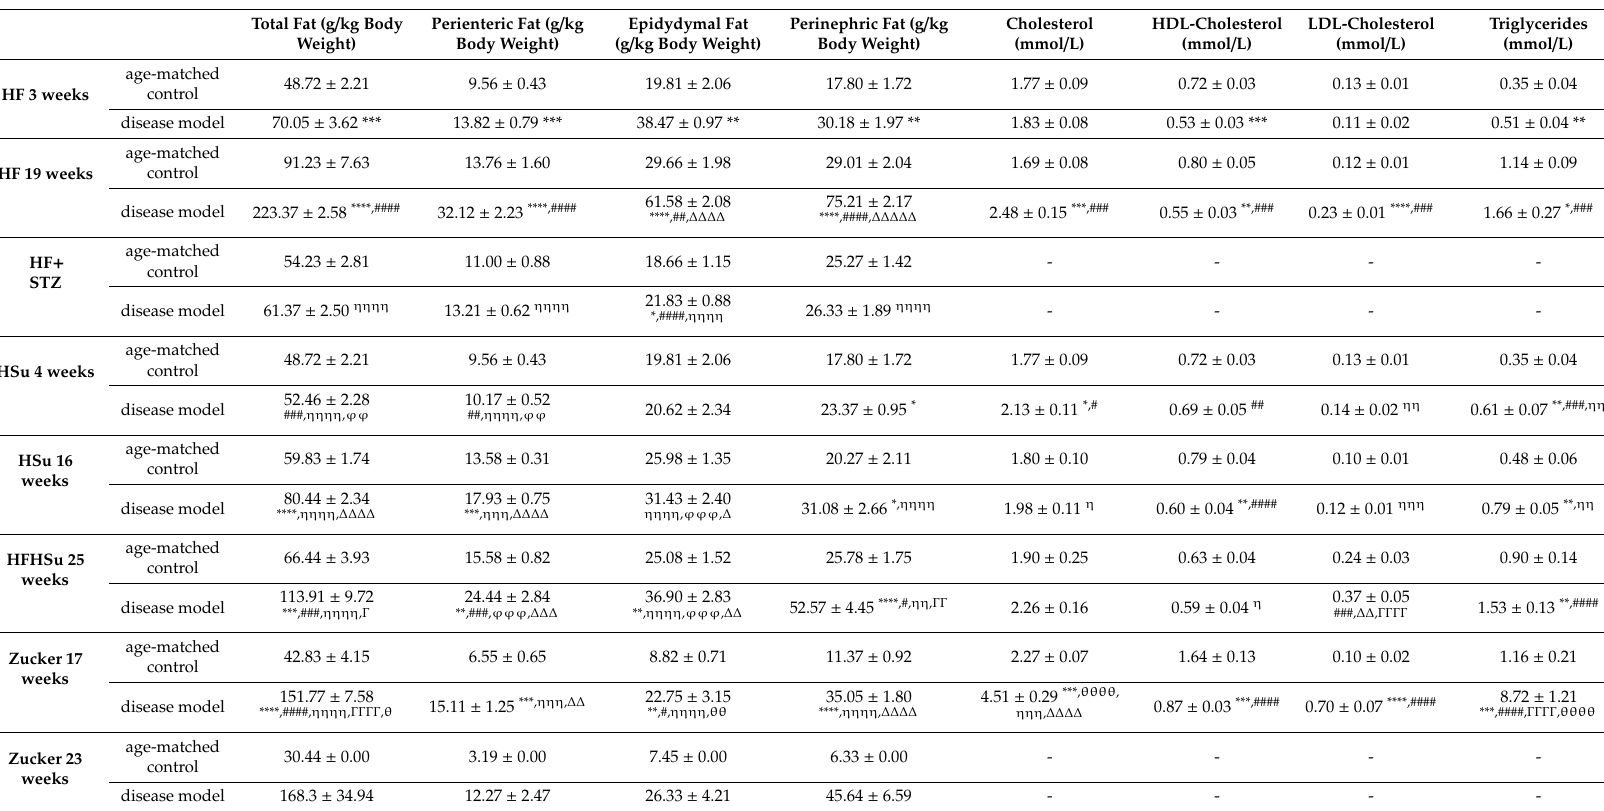
Table 1. Adipose tissue depots and lipid profile (total cholesterol, triacylglycerols, high-density lipoprotein (HDL)–cholesterol and low-density lipoprotein (LDL)–cholesterol) in animal models of obesity and type 2